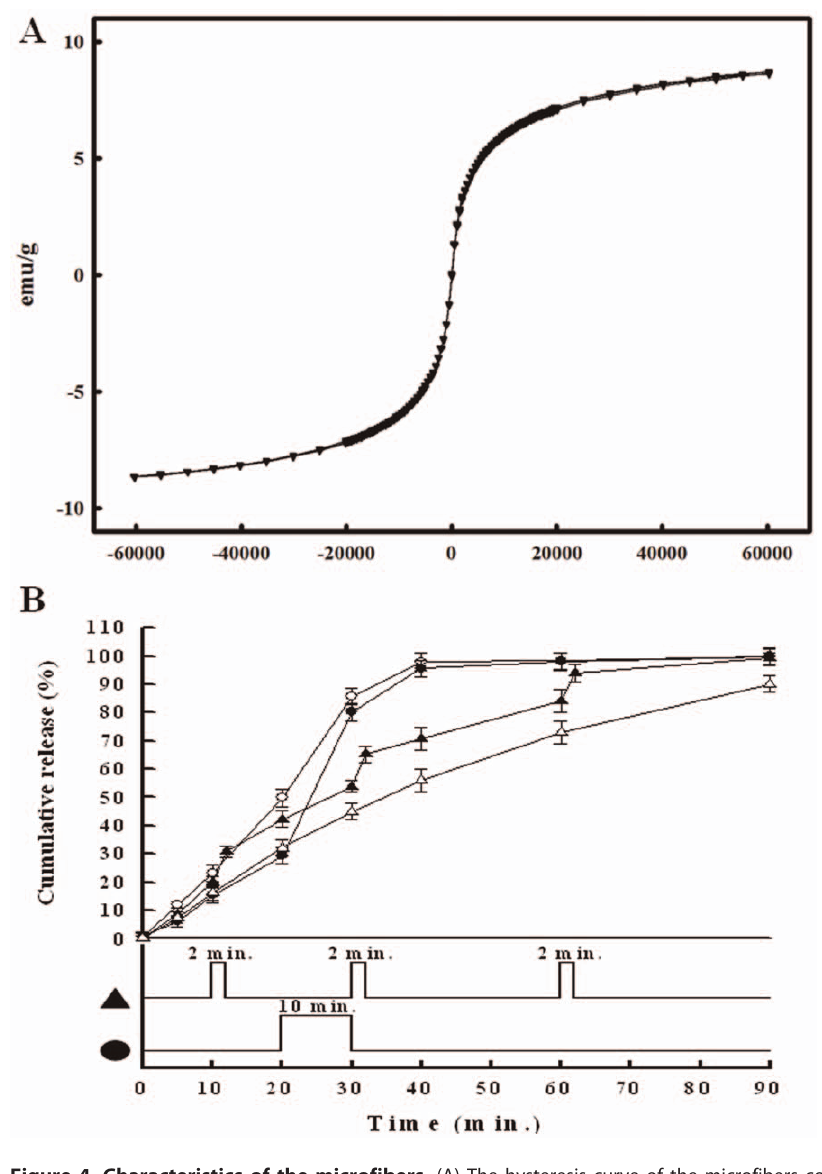
Figure 4. Characteristics of the microfibers. (A) The hysteresis curve of the microfibers containing MIO nanoparticles. (B) Release profiles of N diclofenac from MIO-loaded microfibers without magnetic stimulation as the control ( n ), with 2 minutes stimulation at the 10th, 30th and 60th ) and with a continuous stimulation from the beginning ( # ). minute ( m ), with a 10-minute stimulation after the 20th minutes (